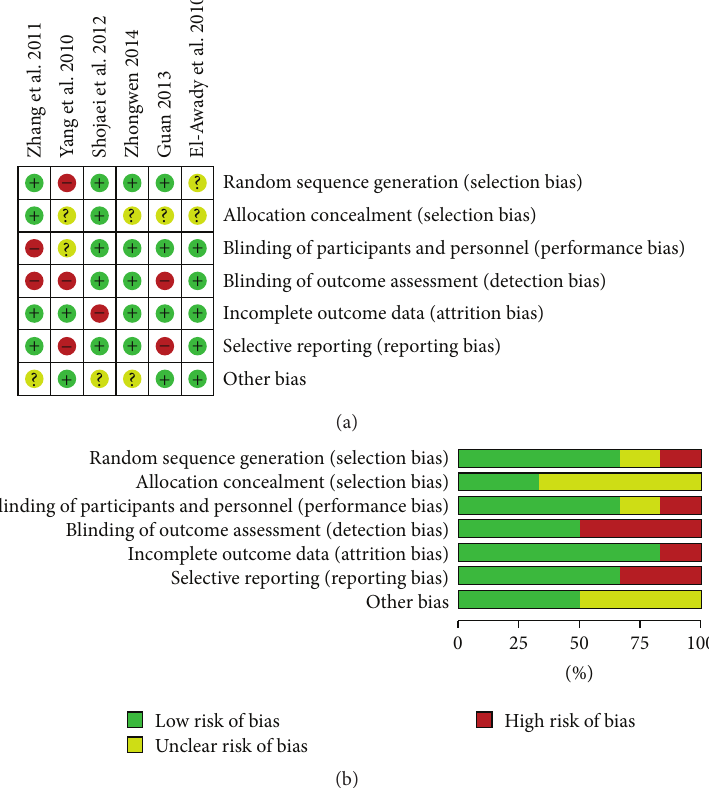
Figure 2: (a) Risk of bias summary: authors’ judgments about each risk of bias item for each included risk. (b) Risk of bias graph: authors’ judgments about each risk of bias item presented as percentages across all included